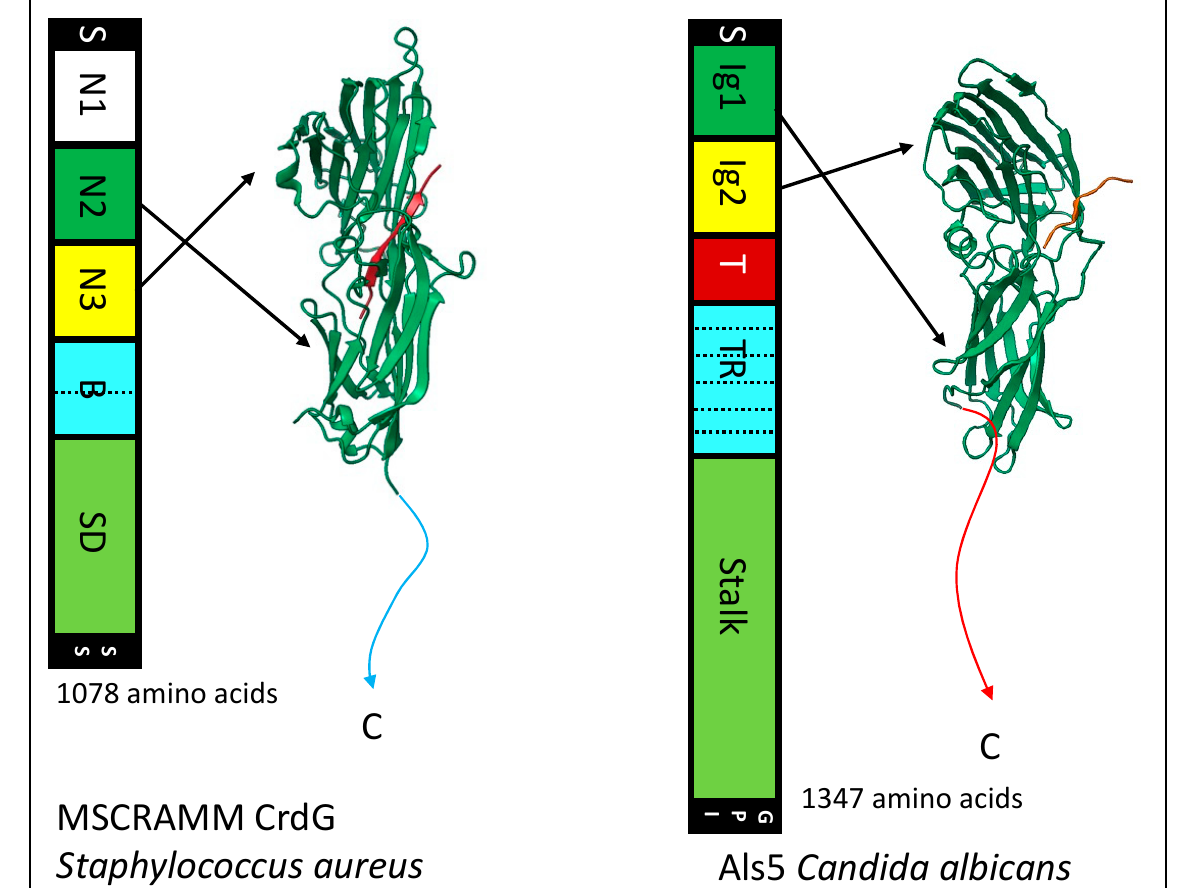
Figure 8. Similarities between a bacterial MSCRAMM and a fungal Als adhesin. In the maps, regions with analogous structures are similarly colored: N-terminal secretion signals (S) and C-terminal wall anchorage signals (SS, bacterial sortase; GPI glycosyl phosphatidyl inositol) are black, Ig-like domains are green and yellow, tandem repeats are light blue, and low-complexity stalk regions are light green (SD, (SerAsp) n repeats). The structural models show the Ig-like domains with the ligand peptides in orange. The CrdG structure is from pdb file 1R17 and the Als3 structure from file 4LEB. The similarities extend to multifunctional properties of these adhesins. Both families mediate microbial binding to abiotic and biological substrata, including indwelling medical devices. Each family shows broad binding to mammalian ECM